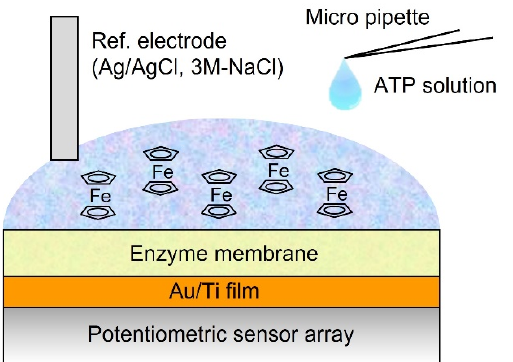
Figure 3. Schematic illustration of a cross − sectional view of experimental setup for ATP sensing.